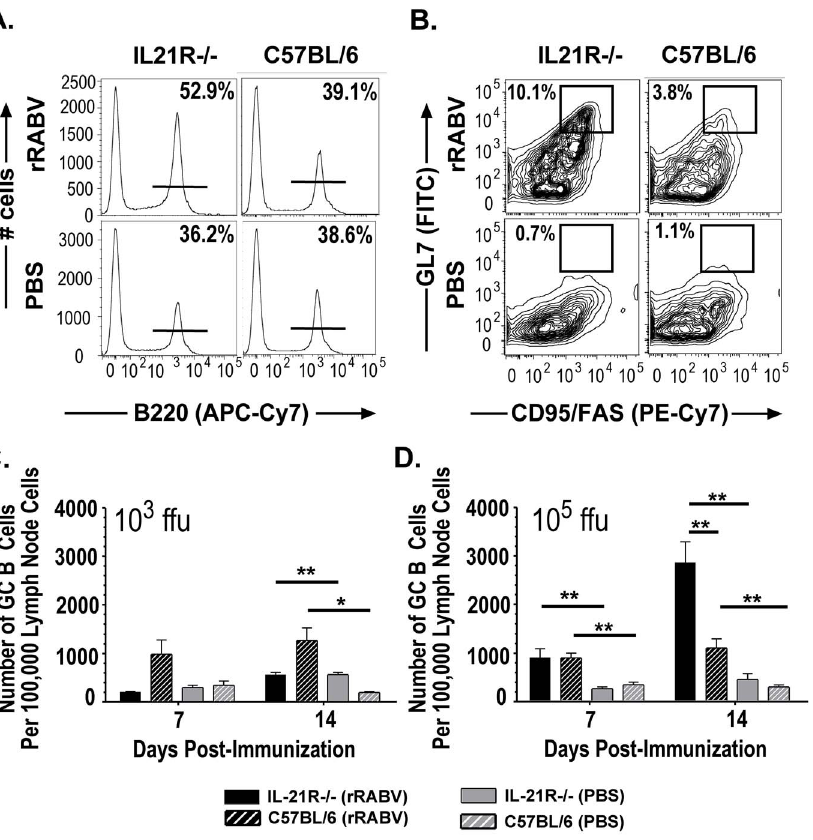
Figure 5. IL-21 promotes optimal GC B cell development in a vaccine dose-dependent manner. Draining lymph node cells from IL-21R 2 / 2 or wild-type C57BL/6 mice immunized in Figure 4 were analyzed for the presence of B cells displaying a GC phenotype (B220 + GL7 hi CD95/Fas hi ). A, Representative gating strategy from IL-21R 2 / 2 or C57BL/6 mice immunized with rRABV or PBS to identify B220 + B cells from total live lymph node cells. B, Representative gating strategy from IL-21R 2 / 2 or wild-type mice immunized with rRABV or PBS to identify GC B cells. C and D, Number of GC B cells per 100,000 draining lymph node cells was determined in IL-21R 2 / 2 or wild-type mice immunized with 10 3 (C) or 10 5 (D) ffu/mouse 7 or 14 days post-immunization with rRABV or PBS alone. Statistical difference in GC B cell data between two groups of data was determined using an unpaired, two-tailed t test and data is presented at the mean 6 SEM. *p , 0.05, **p=0.01–0.001, ***p # 0.001; (N=5 mice per group); (ffu=focus forming